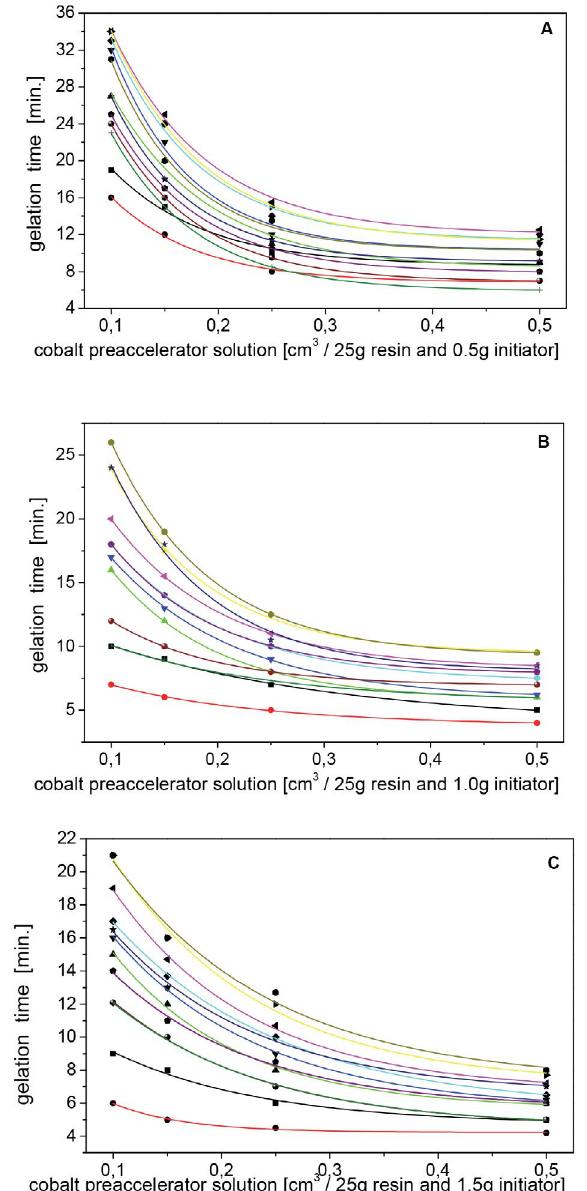
Figure 5. Gelation times of unsaturated polyesters resins with var- ious amount of cobalt accelerator solution and various amounts of chemically incorporated modifier A. To 25 g of resin, 0.5 g (plot A), 1.0 g (plot B), and 1.5 g (plot C) of butanone peroxide initiator was added; the amounts of chemically incorporated modifier A: ( ■ ), 0.002 wt.-%; ( • ), 0.005 wt.-%; ( ▲ ), 0.010 wt.-%; ( ▼ ), 0.020 wt.-%; ( ◆ ), 0.050 wt.-%; (  ), 0.100 wt.-%; (  ), 0.250 wt.-%; (  ), 0.500 wt.- %; (  ), 0.750 wt.-%; (  ), 1.000 wt.-%; (  ), 1.250 wt.-%, (  ) 1.500